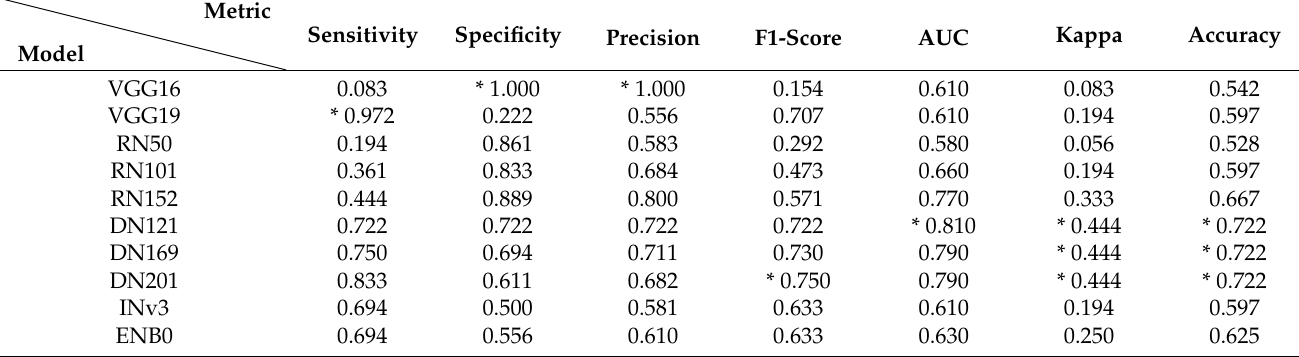
Table 5. Effectiveness of compared CNNs without transfer learning for different metrics. Metric Sensitivity Model